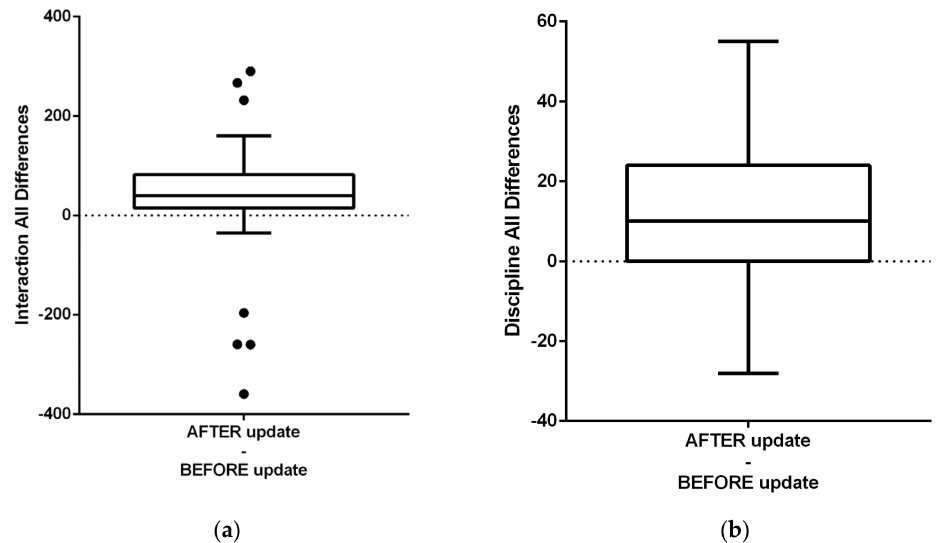
Figure 11. ( a ) Differences before and after update regarding app interaction for all participants. (Paired t test of variable Discipline) Measured parameter represented patient app interaction in easy and mostly fun interactions including sharing on social networks or achieving interesting badges. ( b ) Differences before and after update regarding app interaction for all participants (Paired t test of variable Discipline). Measured parameter represented patient app interaction in difficult and regular way fulfilling required rules of disciplined use that included teeth and appliance cleaning twice a day (separated by 180 min), at least once per day eating and drinking and as well as fitting the aligner out-of-mouth time between 15 and 120 min. This parameter improved significantly as well.